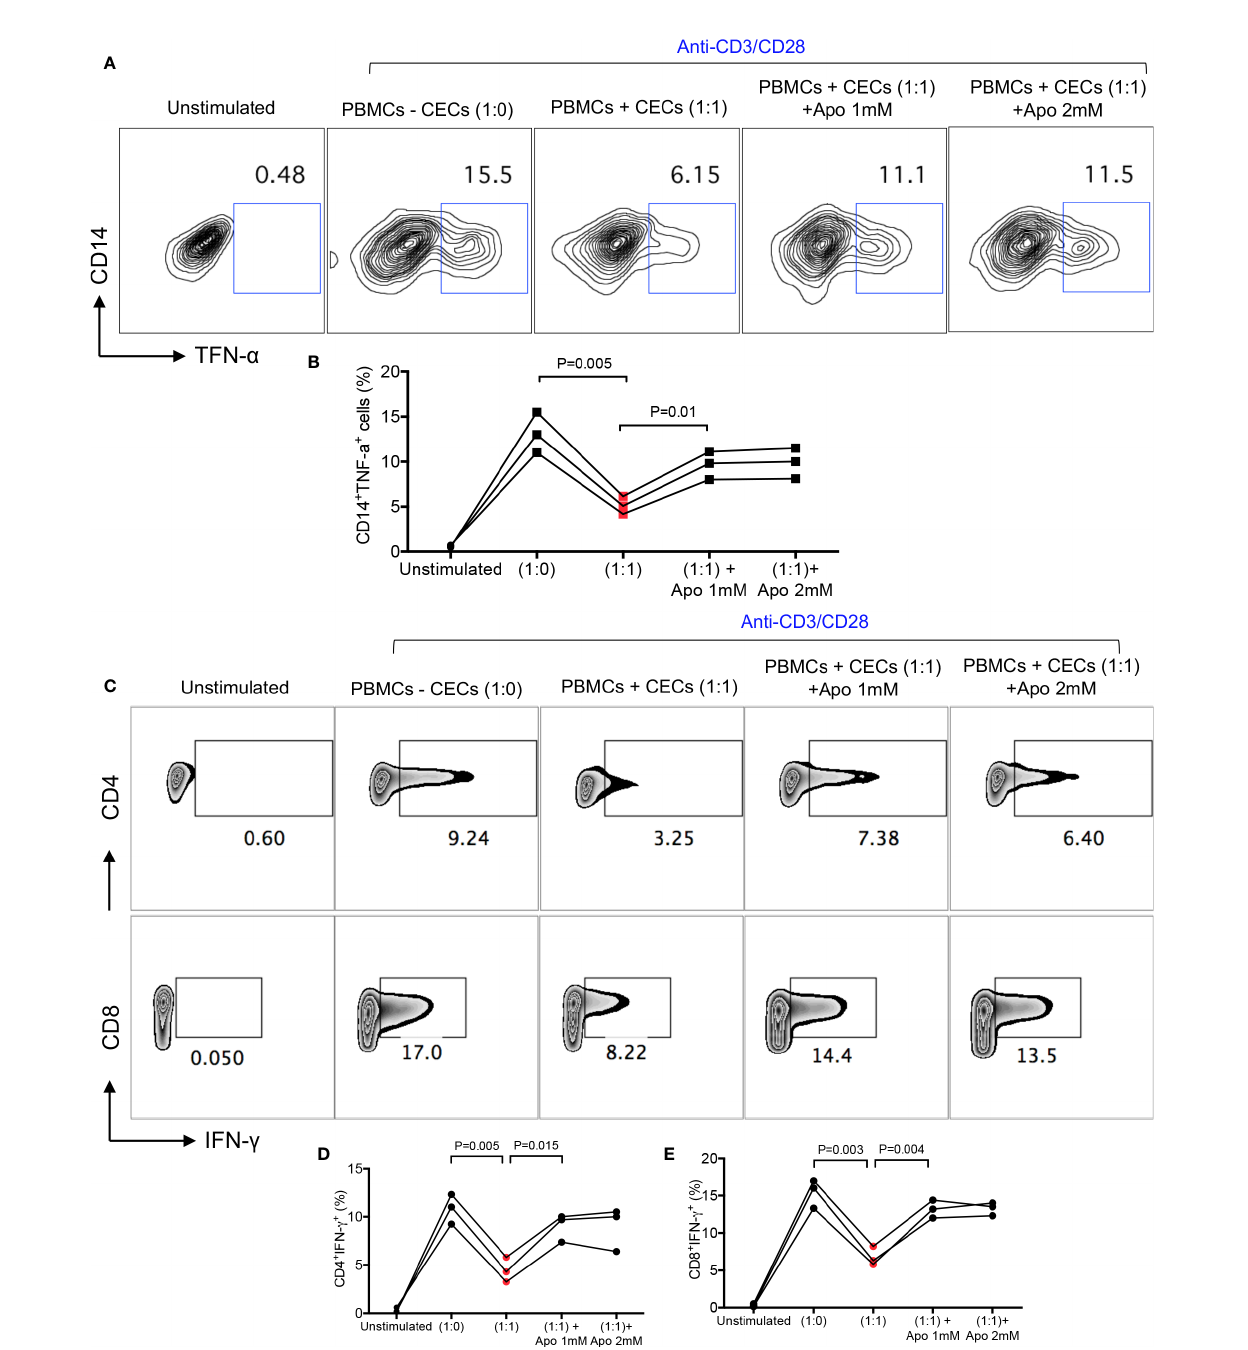
FIGURE 4 | CECs from human infants exhibit immunosuppressive properties in vitro . (A) Representative plots, and (B) cumulative data showing TNF- a production by CD14+ cells following stimulation with LPS (2 m g/ml) in the absence/presence of CECs (1:1) ratio and presence of apocynin at shown concentrations for 6 h with a Golgi blocker. Samples are from three infants aged 2 – 4 weeks. (C) Representative plots, and (D) cumulative data showing IFN- g production by CD4 + or (E) CD8 + T cells following stimulation with anti-CD3/CD28 in the absence/presence of CECs (1:1) ratio and presence of apocynin at shown concentrations for 18 h with an additional 6 h in the presence of a Golgi blocker. Samples are from three infants age 2 to 4